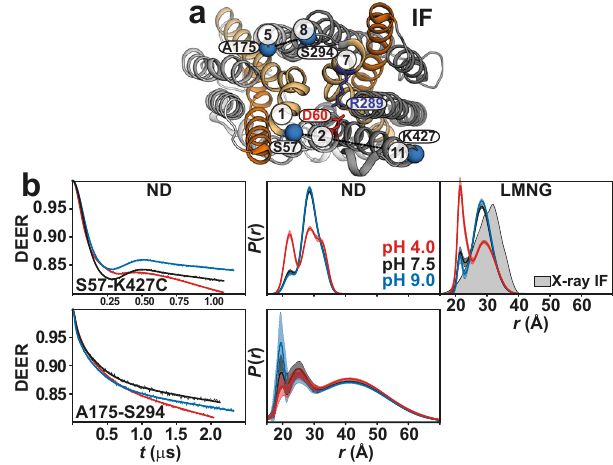
Fig. 4 | Enhanced periplasmic fl exibility of Hn Spns by protonation, with a lat- eralopeningbetweenTMs5and8.a Spinlabelpairs(bluespheres)onthegating helices across the NTD and CTD are depicted on the periplasmic side. b Raw DEER decays and fi ts (left) are presented for the distance distributions P ( r ) in lipid nanodiscs(middle)and in LMNG micelles(right).The distributions predicted from the IF crystal structure are shaded gray.